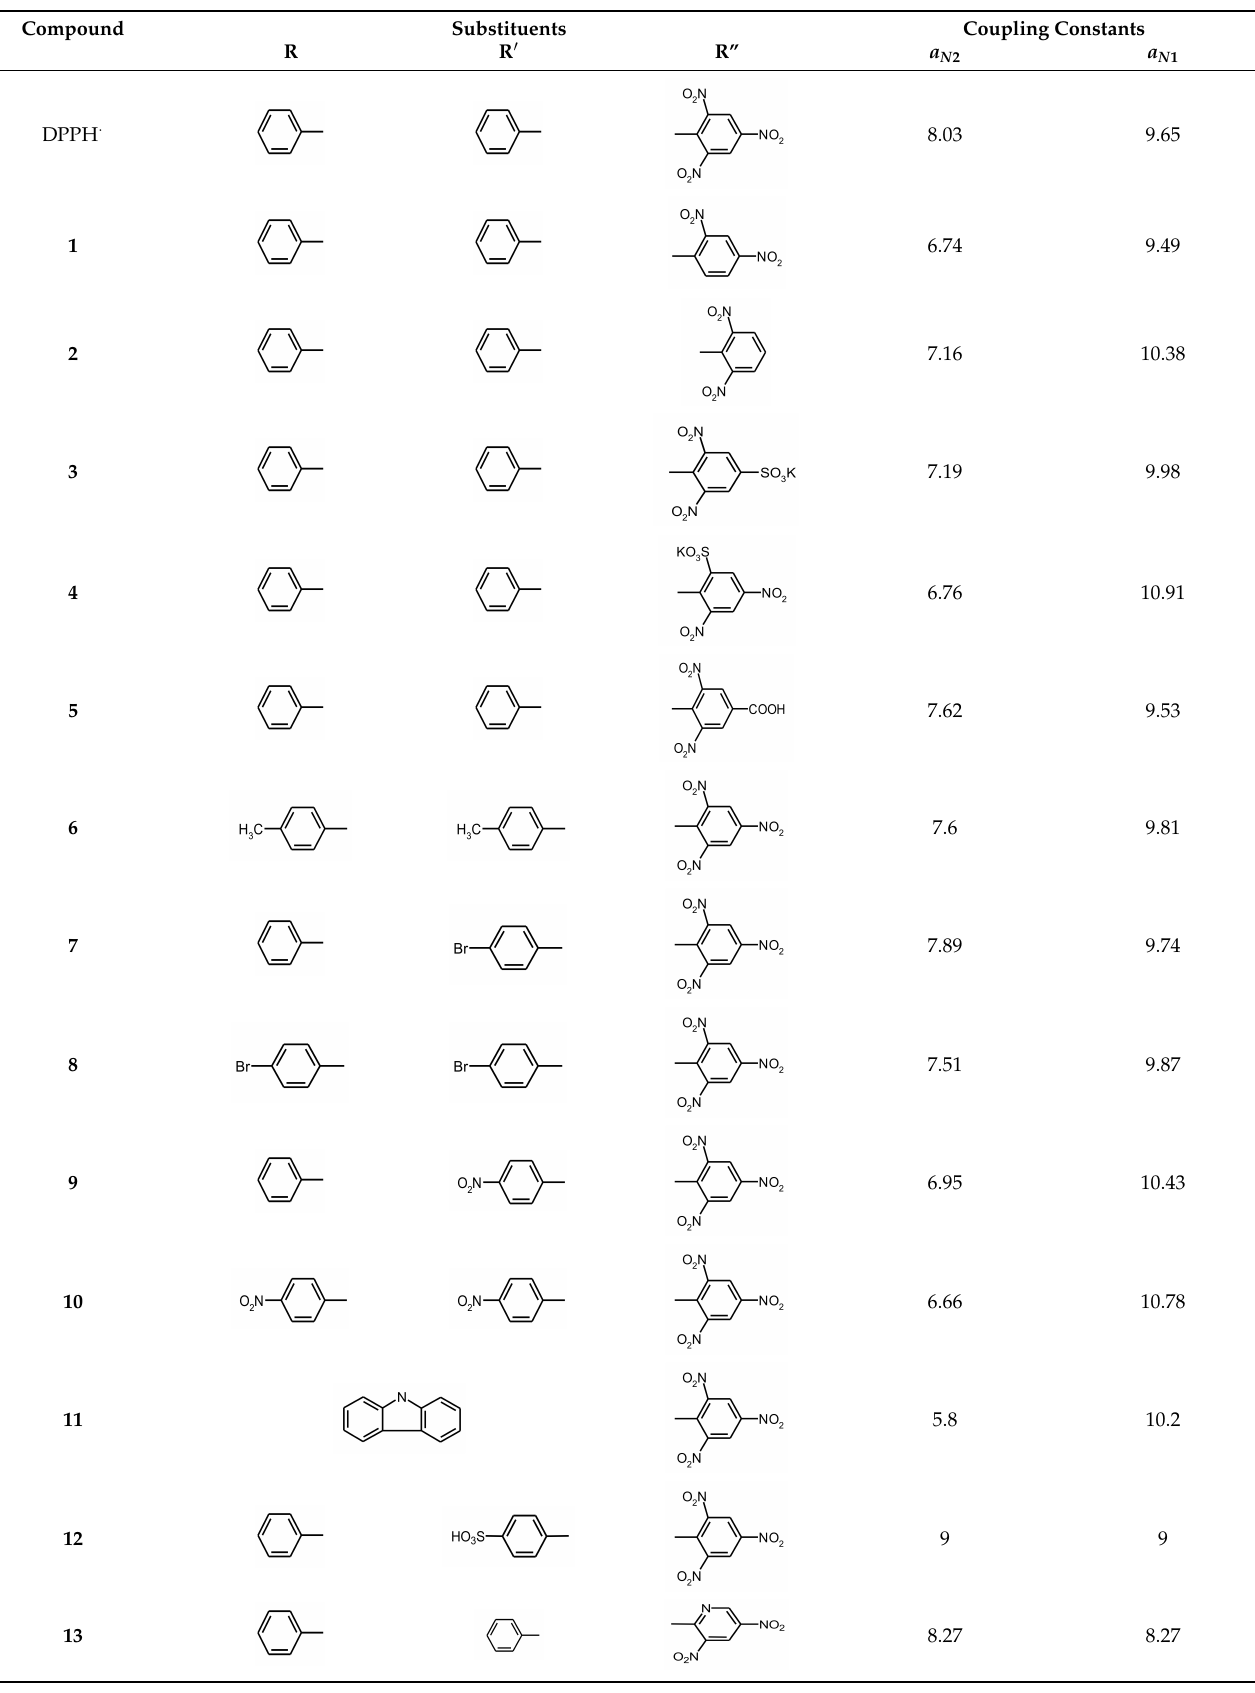
Table 1. Electron Spin Resonance (ESR) coupling constants (G) for several hydrazyl free radicals.